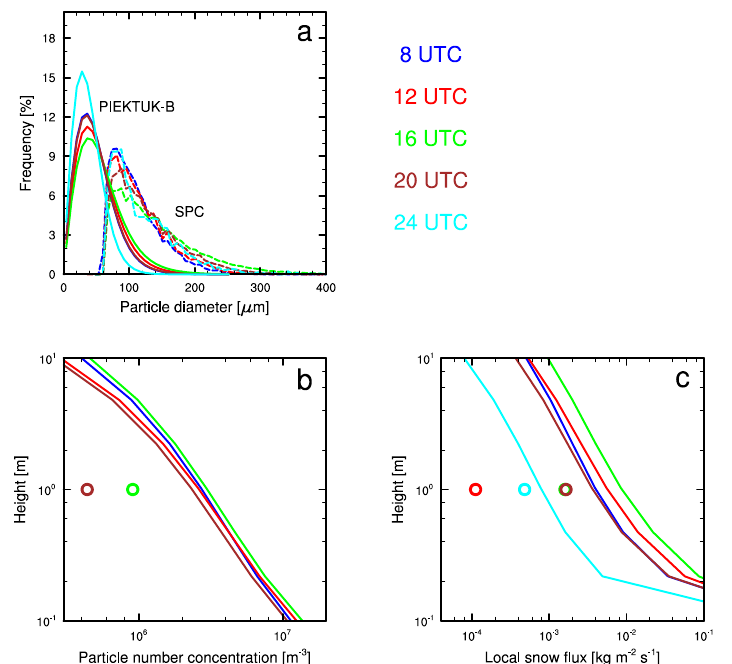
Fig. 14. Snapshots of drifting snow characteristics during 26 September 2012. (a) Relative frequency of drifting snow particle sizes at 1m above the surface according to PIEKTUK-B (solid lines) and observations (dotted lines); (b) and (c) vertical profiles of simulated particle concentration and horizontal snow flux (solid lines) and observed particle concentration and horizontal snow flux at ∼ 1m height (filled